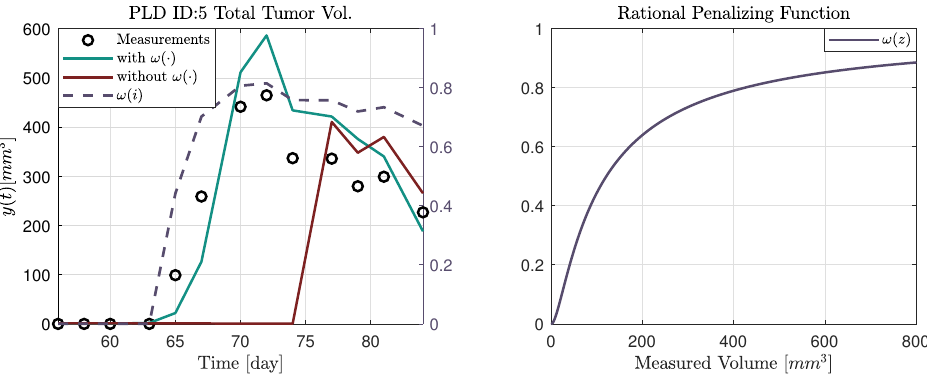
Figure 4. Effect of the rational penalizing